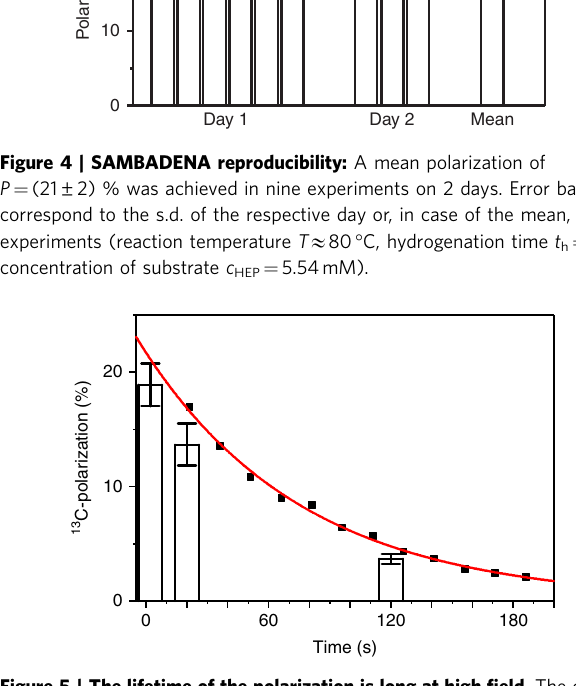
Figure 5 | The lifetime of the polarization is long at high field. The decay of one sample of hyperpolarized 13 C-HEP was monitored by acquiring 12 non-localized spectra with a repetition time of T R ¼ 15s and a small flip angle of 9 (cid:2) (squares). A mono-exponential decay function (line) was fitted to the data and yielded T 1 B (79 ± 2) s. A correction factor—described in the methods—was applied to each data point to compensate for the fact that each measurement pulse consumes a finite amount of the magnetization. The T 1 determined from the low flip angle measurement correlates well to the polarizations that were detected by full, 90 (cid:2) excitations 0, 20 and 120 s after the HP. For each time point, the mean of three measurements (bars) is shown, and error bars indicate the s.d. The tracer concentration was 5.54mM in D 2